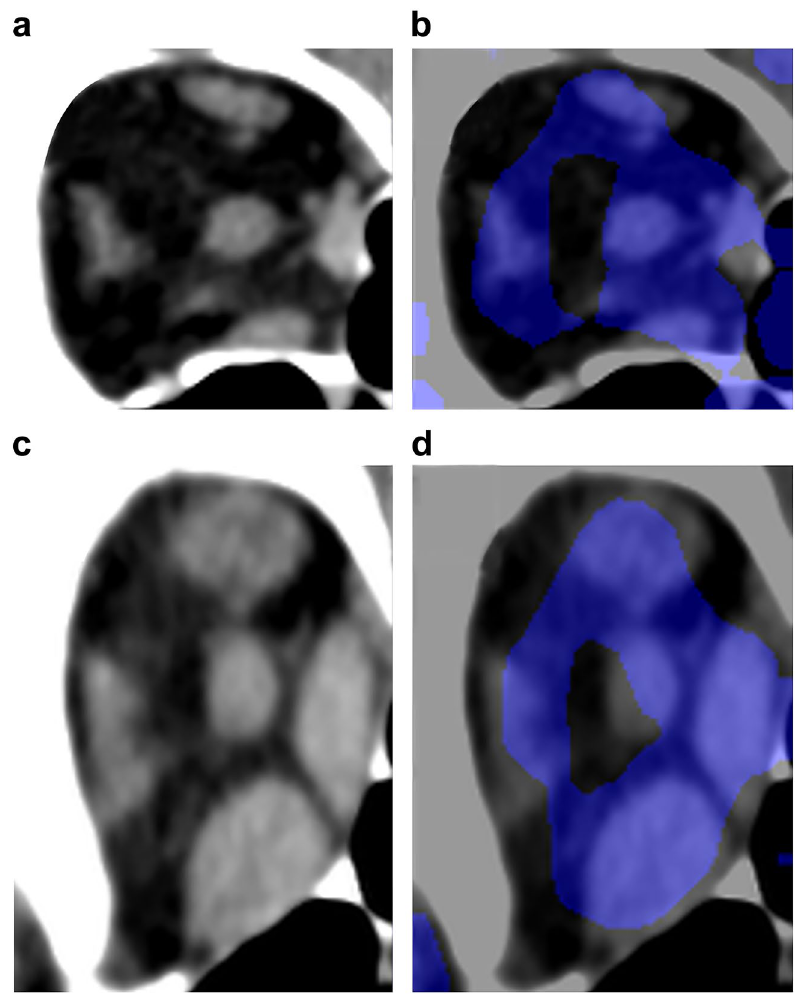
Figure 2. The computed tomographic (CT) slice image ( a ) and the heat map ( b ) for a healthy participant. The CT slice image ( c ) and the heat map ( d ) for a patient with Graves’ ophthalmopathy. Blue coloration indicates the strength of deep neural network attention. The color intensity is high at the area of the rectus muscles on the orbital coronal CT image. The deep neural network classifies the extraocular muscles as enlarged in the patient with Graves’ ophthalmopathy and as normal in the controls, focusing on the rectus